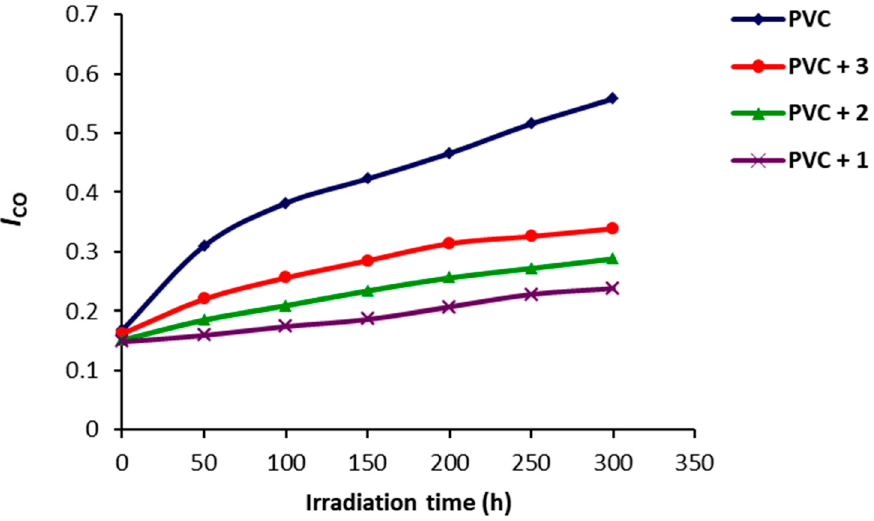
Figure 3. Effect of irradiation of PVC films on I CO .